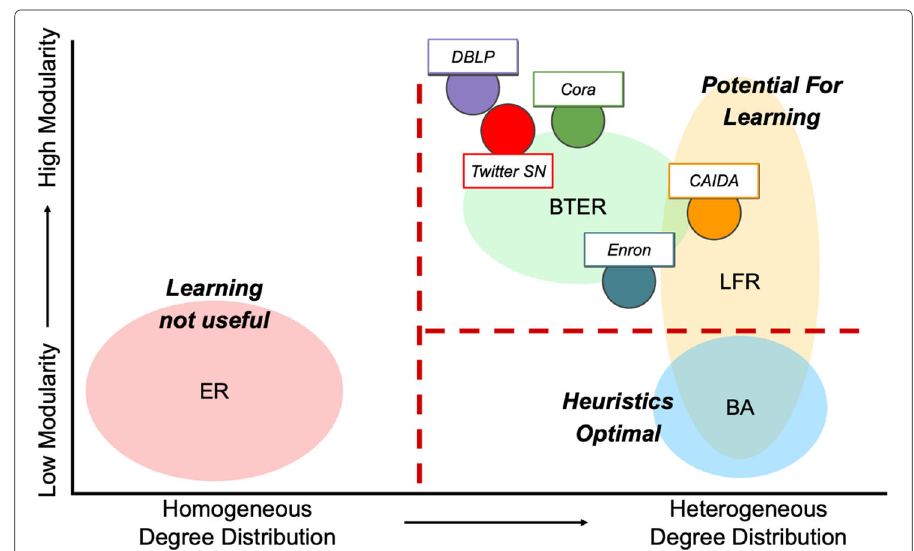
Fig. 1 We present the conditions under which network online learning is feasible. In particular, there is a potential for learning a policy to reduce incompleteness of a network onlyif the network has heterogenous degree distribution and high modularity. The synthetic graphs in the figure are ER (Erdös-Rényi), BA (Barabási-Albert), BTER (Block Two-level Erdös-Rényi), and LFR (Lancichinetti-Fortunato-